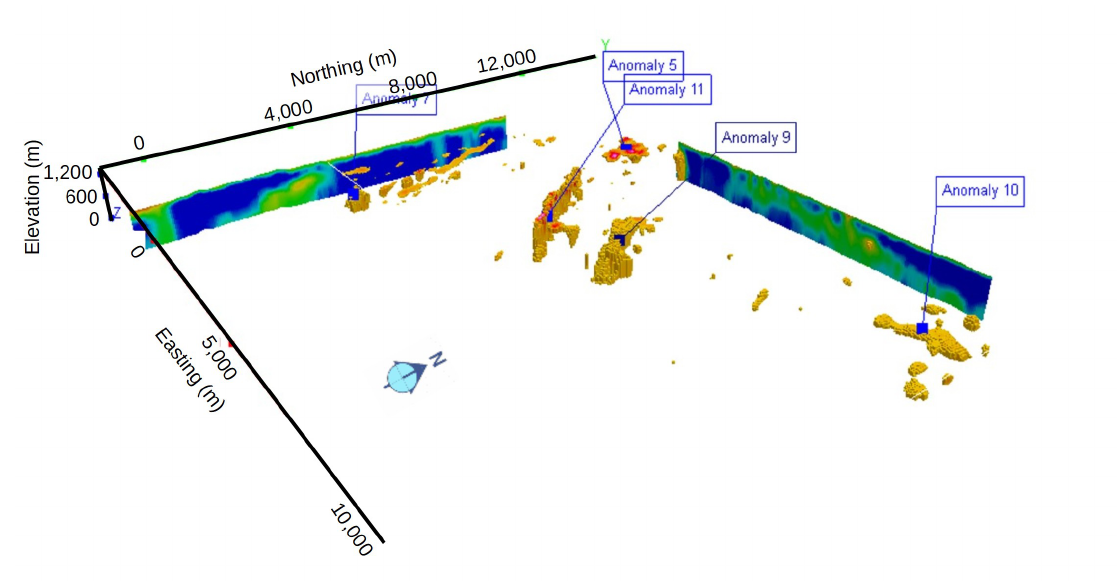
Figure 9. Local anomalies identified within the “Glass Earth” model. The image shows the conductivity model. Two vertical sections of conductivity are shown. Voxels with conductivities greater than 100 mS/m are shown. Hot colors are conductive, and cool colors are resistive.